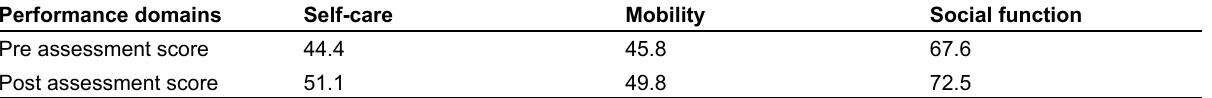
Table 3. PEDI: initial evaluation compared to the final assessment (TX after 32 months): scaled scores Performance domains